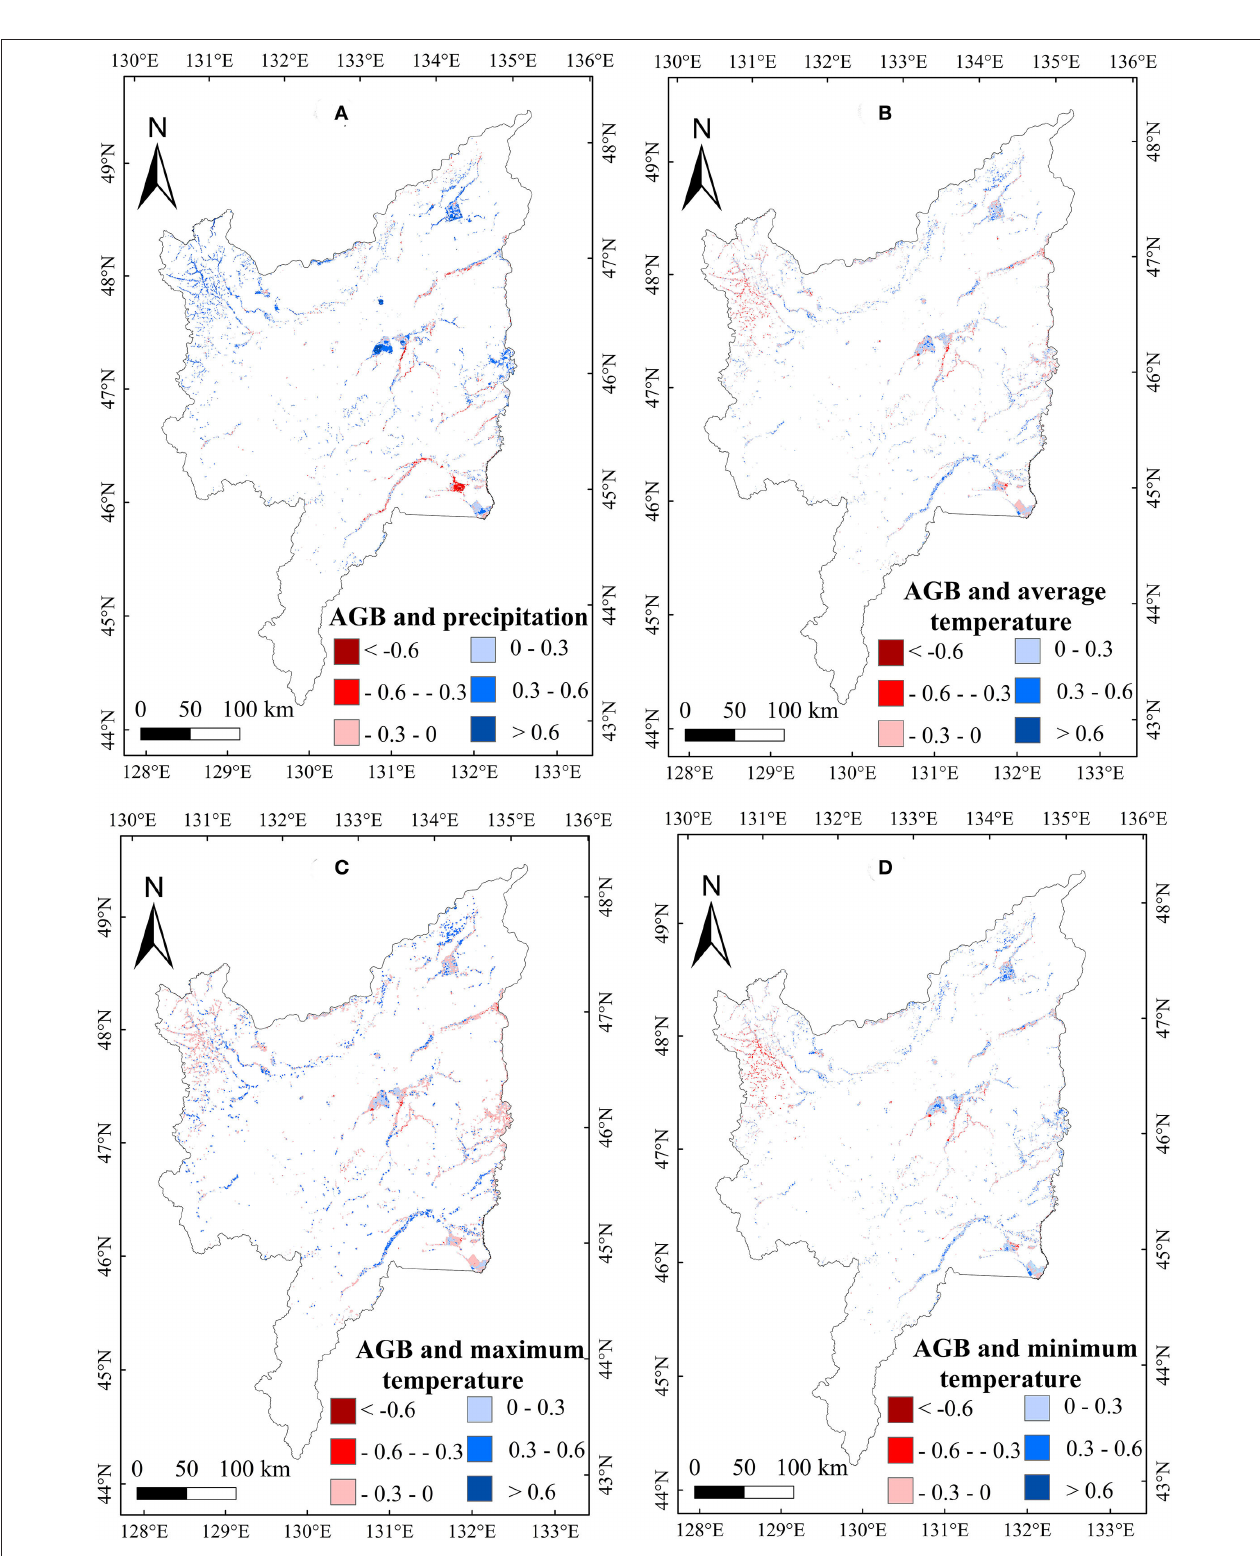
FIGURE 5 | Spatial patterns in relationships of marsh AGB with annual precipitation (A) , T mean (B) , T max (C) and T min (D) on the Sanjiang Plain marshes from 2000 to 2020.